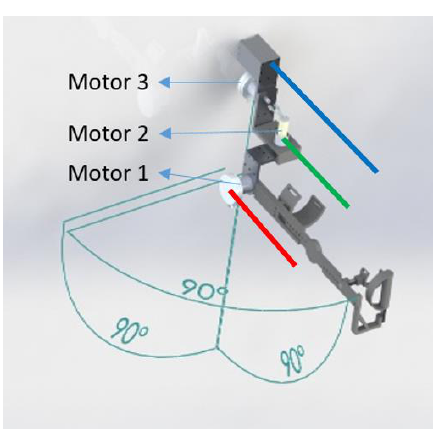
Figure 9. Location of motors and joint